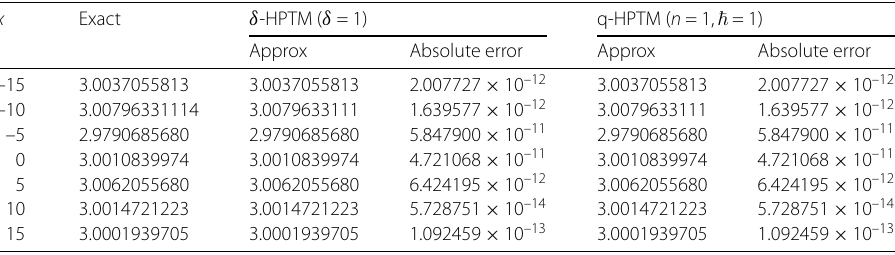
Table 1 The comparative study of Re[ W (3) ] solutions of δ -HPTM, q-HATM, and exact solution for